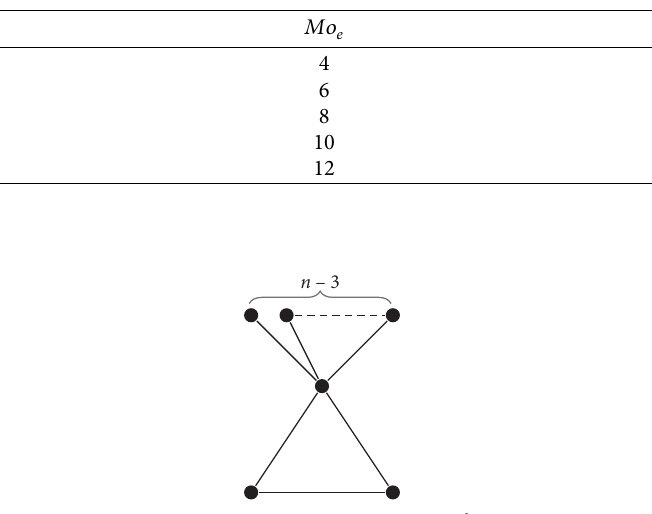
Table 1: The edge Mostar index of graphs in Figure 7.